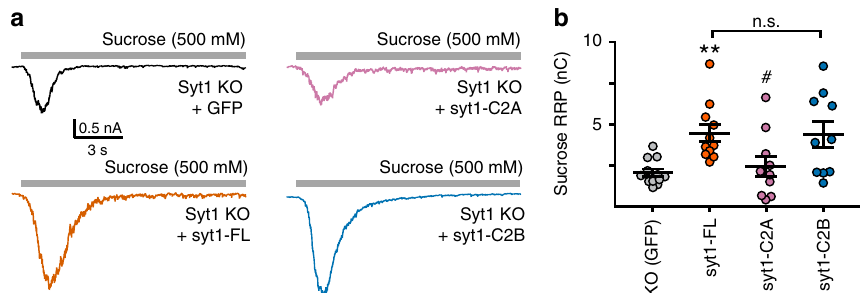
Fig. 3 The syt1-C2B, but not syt1-C2A, rescues the RRP in syt1 KO neurons. Example traces ( a ) and quanti fi cation ( b ) of the readily releasable pool (RRP) elicited by the acute application of hypertonic sucrose (500 mM, 15 sec). The RRP was measured as the area under the curve prior to the onset of steady- state release (indicative of replenishment). Error bars represent s.e.m